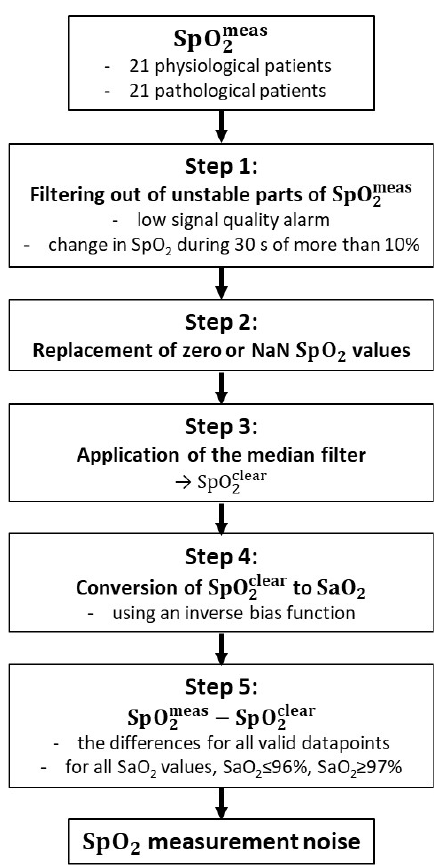
Figure 3. Data-processing flowchart for SpO 2 measurement noise estimation.